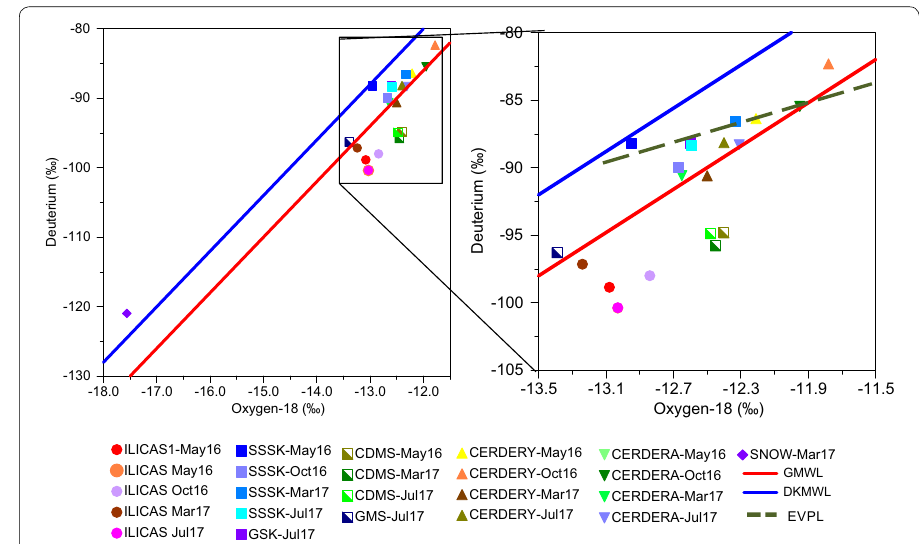
Fig. 13 δ 18 O–δ 2 H diagram for waters in the Şavşat Geothermal Field ( GMWL Global Meteoric Water Line, DKMWL Eastern Black Sea Meteoric Water Line, EVPL Evaporation